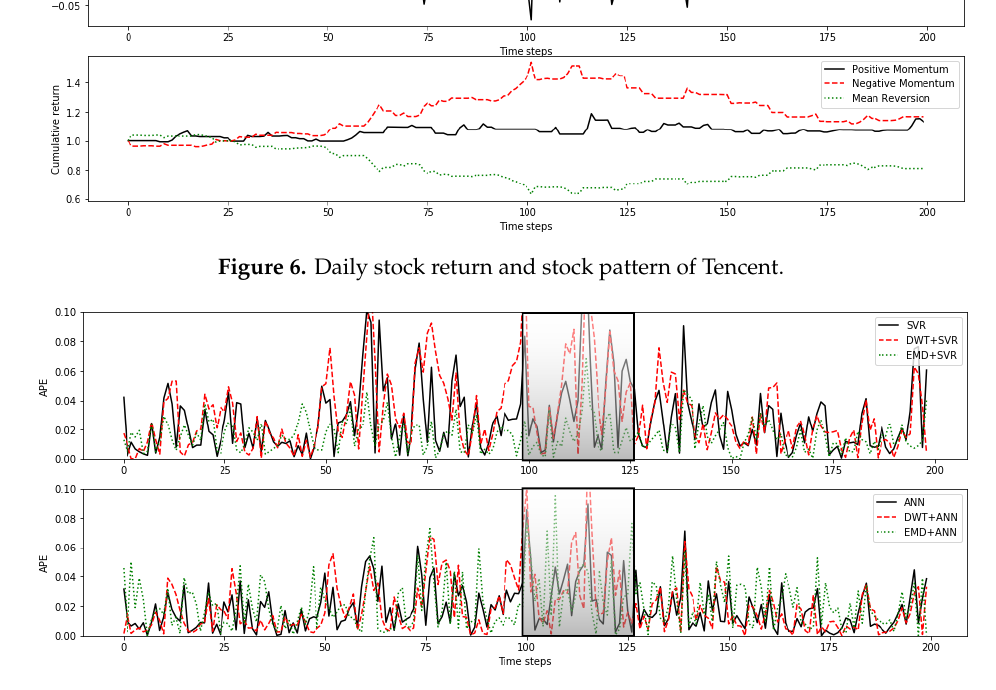
Figure 7. MAPE of different models for Tencent.